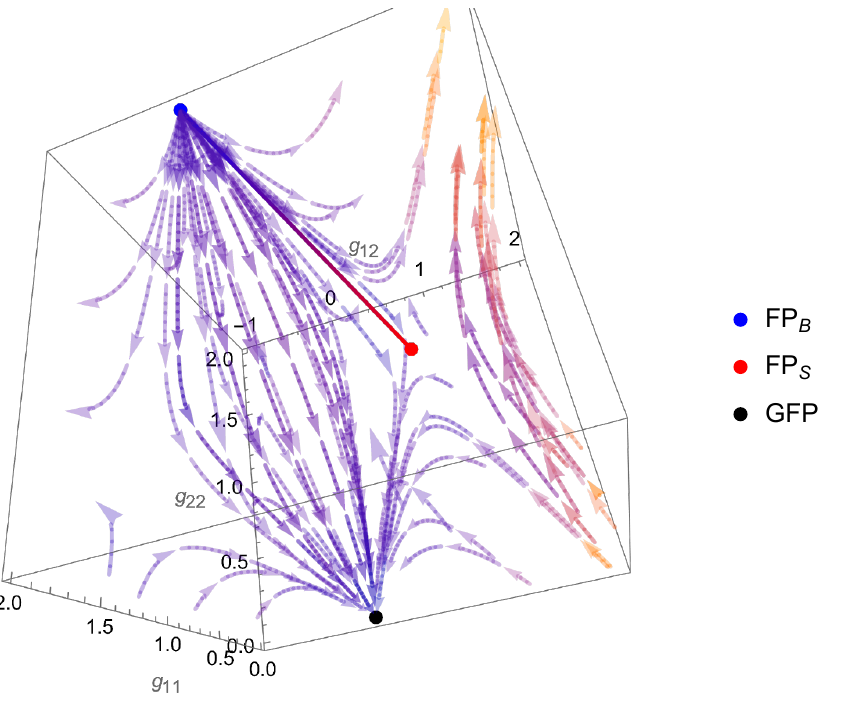
Figure 3 . Streamplot of the RG flow for the fermionic model for the bicritical flow with both ranks equal to 1000. The straight line represents a single step of the type of eq. (4.14). The direction of the flow is following the directions of the arrows, or equivalently from blue to red on the highlighted single-step trajectory. The fixed points FP S (resp. FP B ) corresponds to the fixed point of the (un)broken configuration, while GFP represents the Gaussian fixed point of zero